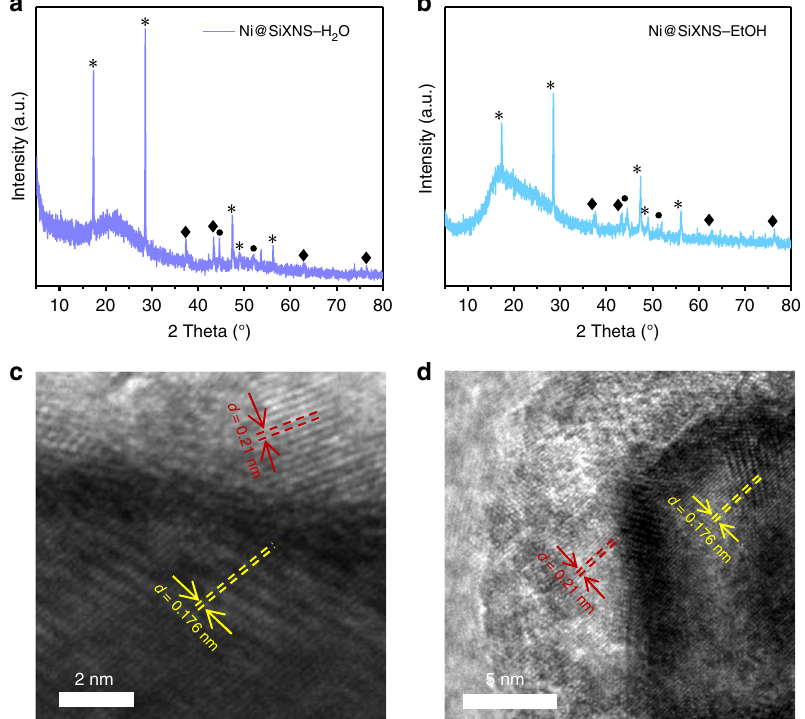
Fig. 4 Characterization of Ni@SiXNS Materials. a , b PXRD patterns showing characteristic peaks from the ( ● ) Ni, ( ♦ ) NiO, and (*) SiXNS constituents of a Ni@SiXNS-H 2 O and b Ni@SiXNS-EtOH. c , d TEM images of c Ni@SiXNS-H 2 O and d